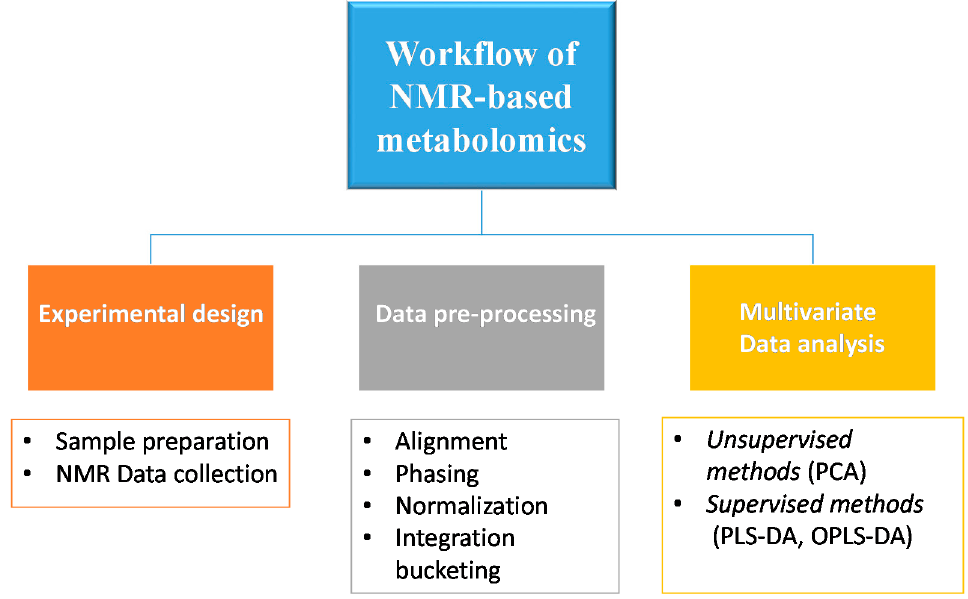
Figure 2. Schematic representation of the basic workflow of NMR-based metabolomics.